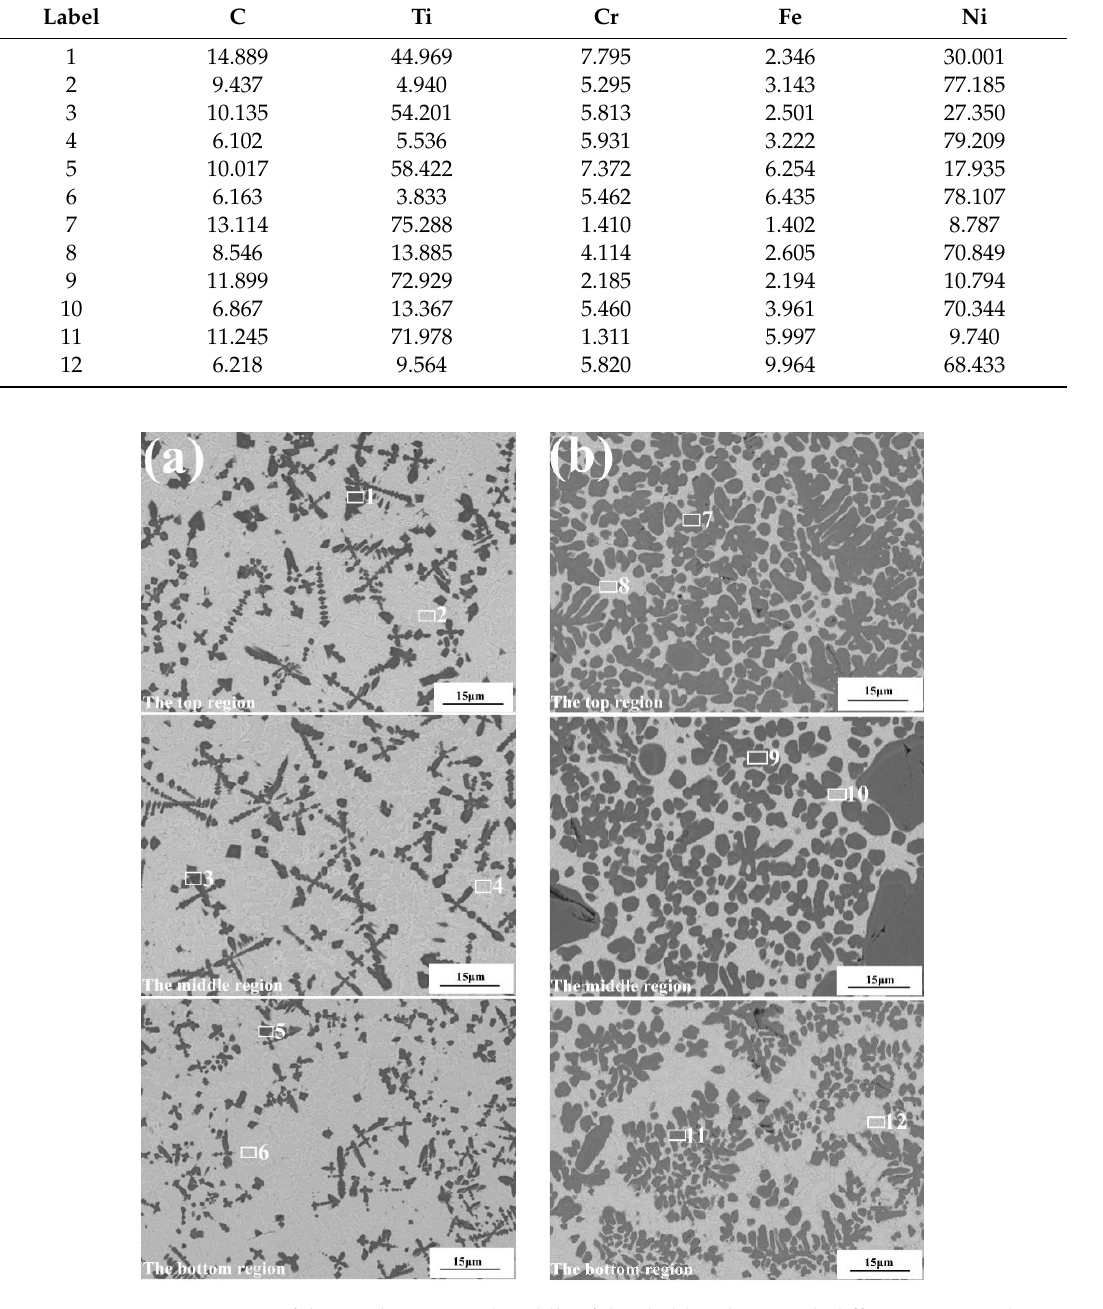
Figure 9. Microstructure of the top, bottom, and middle of the cladding layer with different TiC powder ratios: ( a ) 12# sample, 1.2 kW, 5 mm/s, 1000 L/h, 20% TiC; ( b ) 11# sample, 1.2 kW, 5 mm/s, 1000 L/h, 60% TiC.